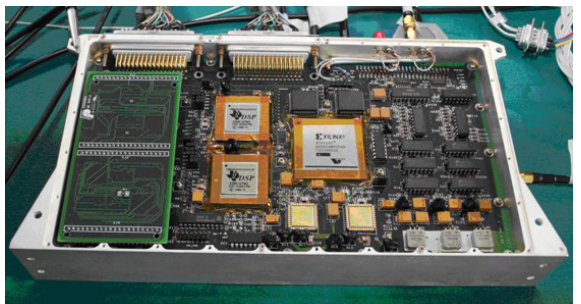
Figure 4. Signal processing hardware platform, including the K/Ka-band dual-frequency MWR processing module, BeiDou III B1C/B2a dual-frequency navigation processing module, and external interface